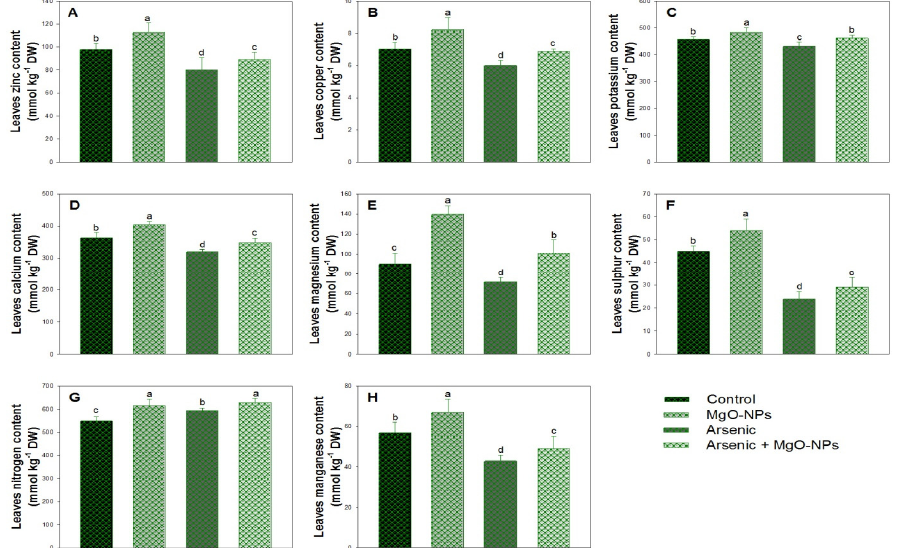
Figure 5. Leaf content in zinc (Zn) ( A ), copper (Cu) ( B ), potassium (K) ( C ), calcium (Ca) ( D ), magnesium (Mg) ( E ), sulfur (S) ( F ), nitrogen (N) ( G ) and manganese (Mn) ( H ) of soybean plants before and after foliar spray of MgO-NPs in the presence/absence (control) of As. Error bars represent standard deviation and different letters indicate significant differences at p < 0.05.